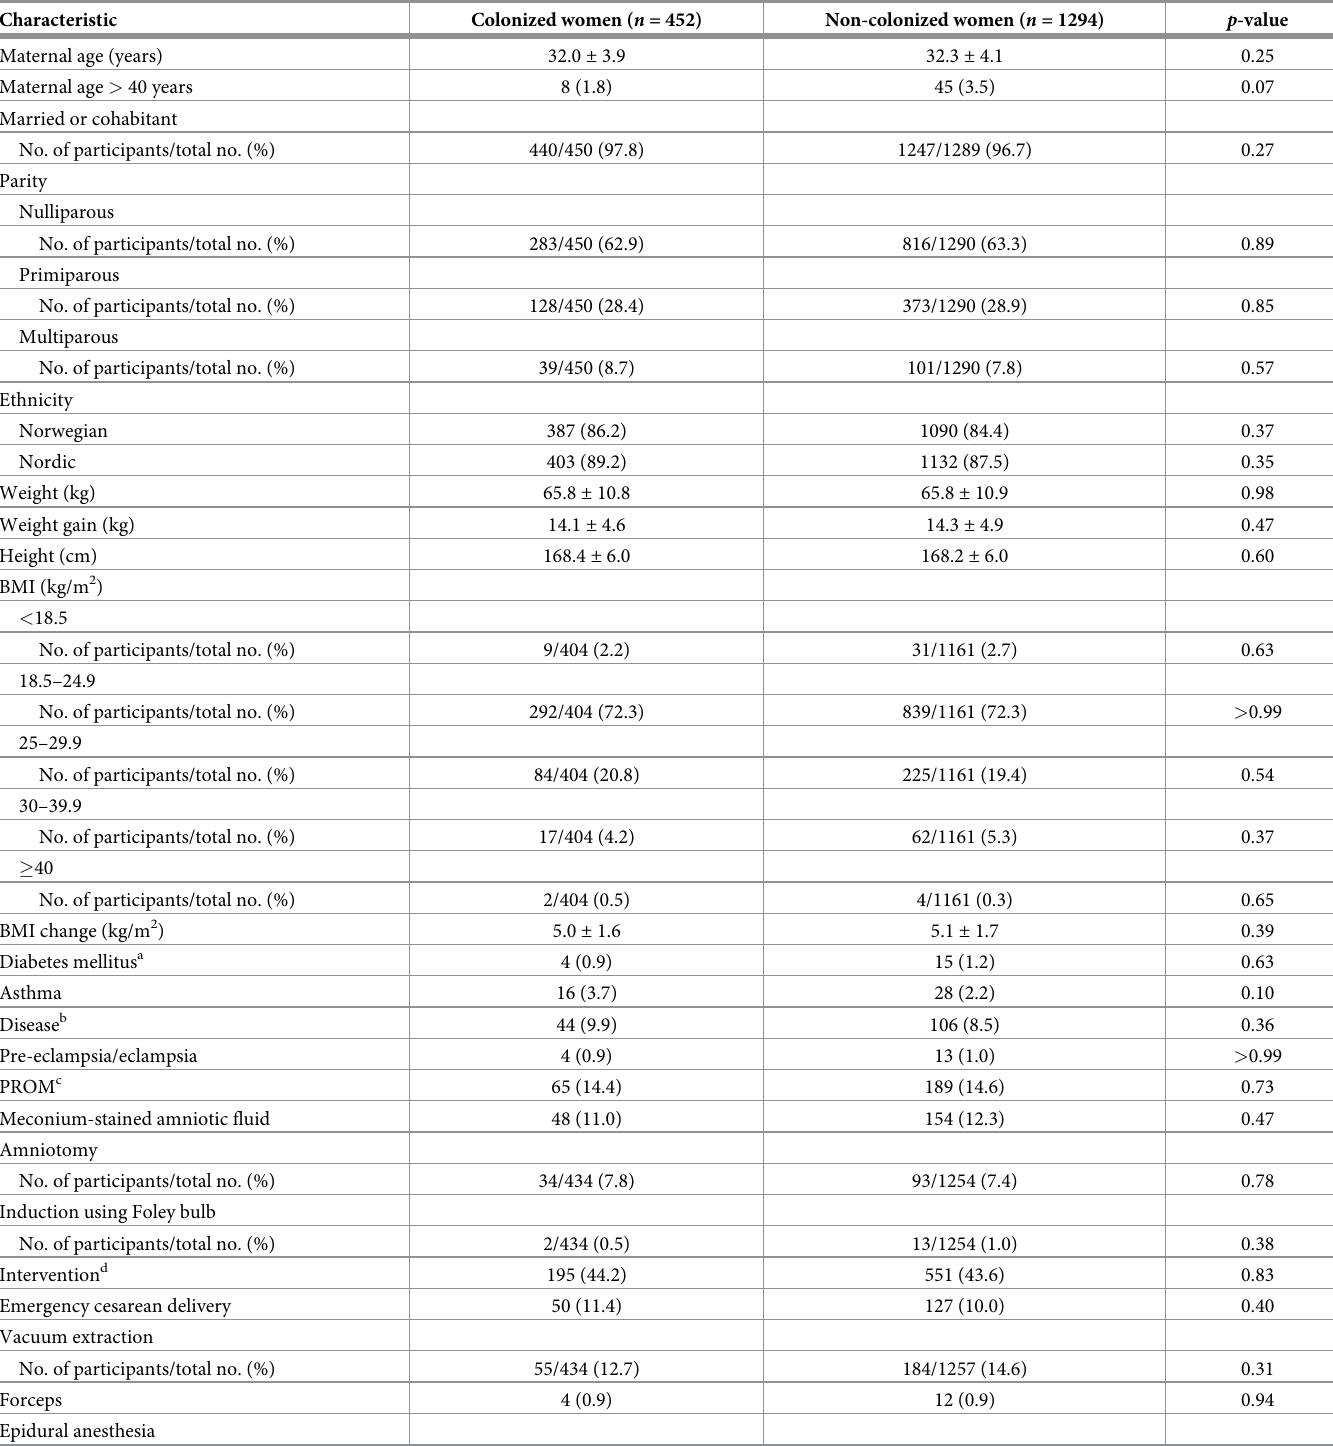
Table 1. Characteristics of GBS colonized and non-colonized